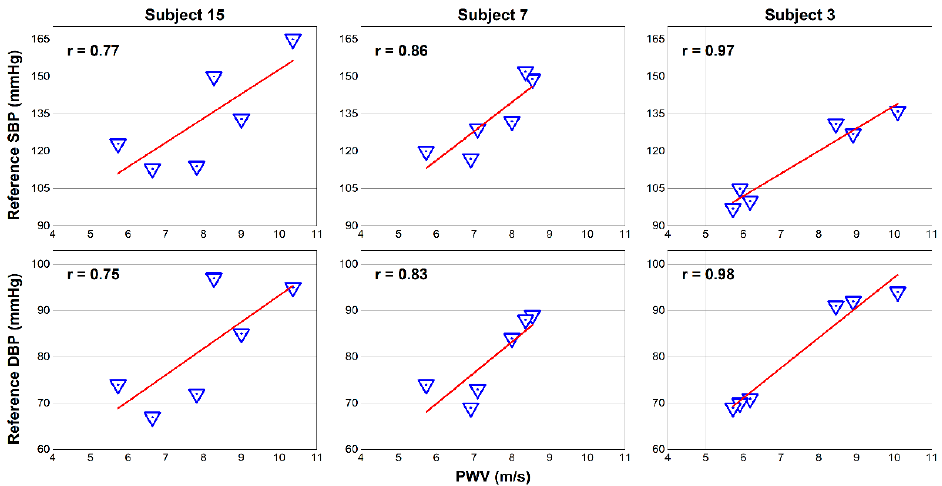
Figure 13. Representative correlation plots between calculated PWV and reference BP.